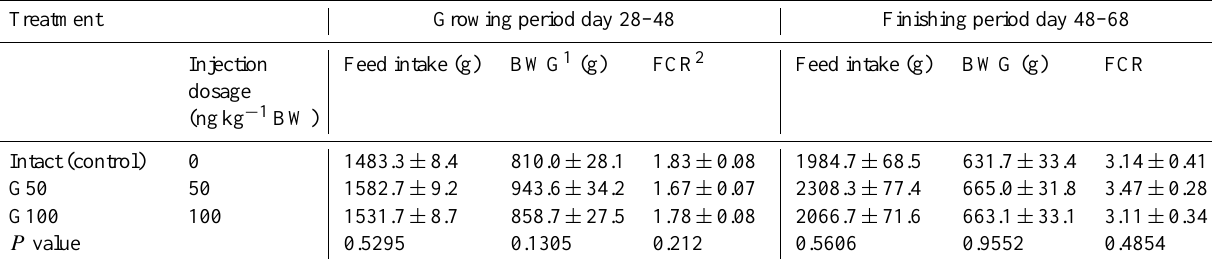
Table 2. Performance of geese subjected to IP injection of ghrelin. Treatment